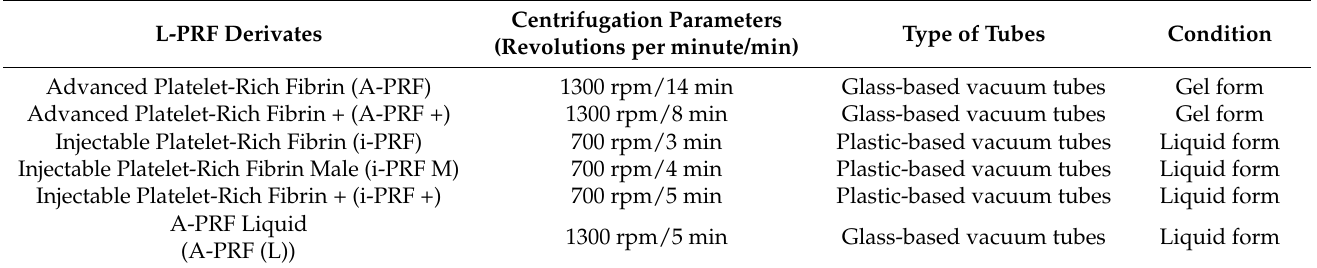
Table 2. Classification of L-PRF derivates